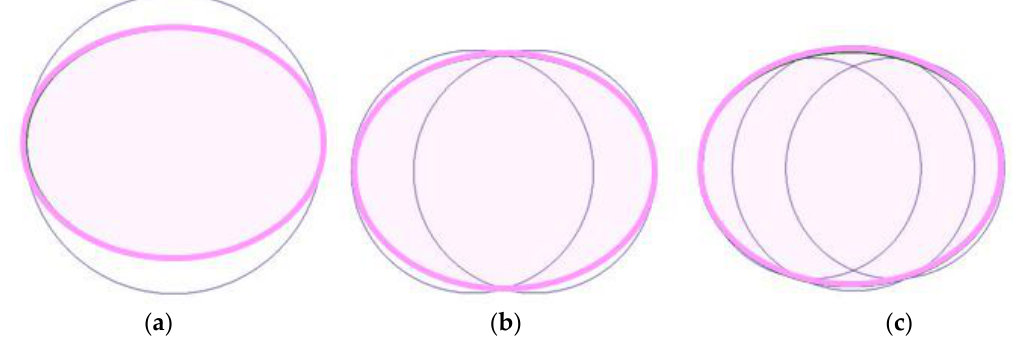
Figure 5. The optimized cover of the ellipse E: ( a ) by M ∗ = 1 circle; ( b ) by M ∗ = 2 circles; and ( c ) by M ∗ = 3